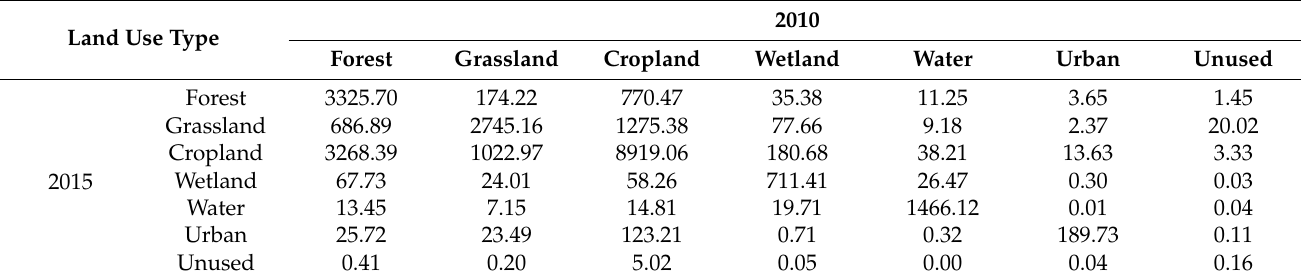
Table A4. Transfer matrix of land use types in Rwanda from 2010 to 2015 (km 2 ).